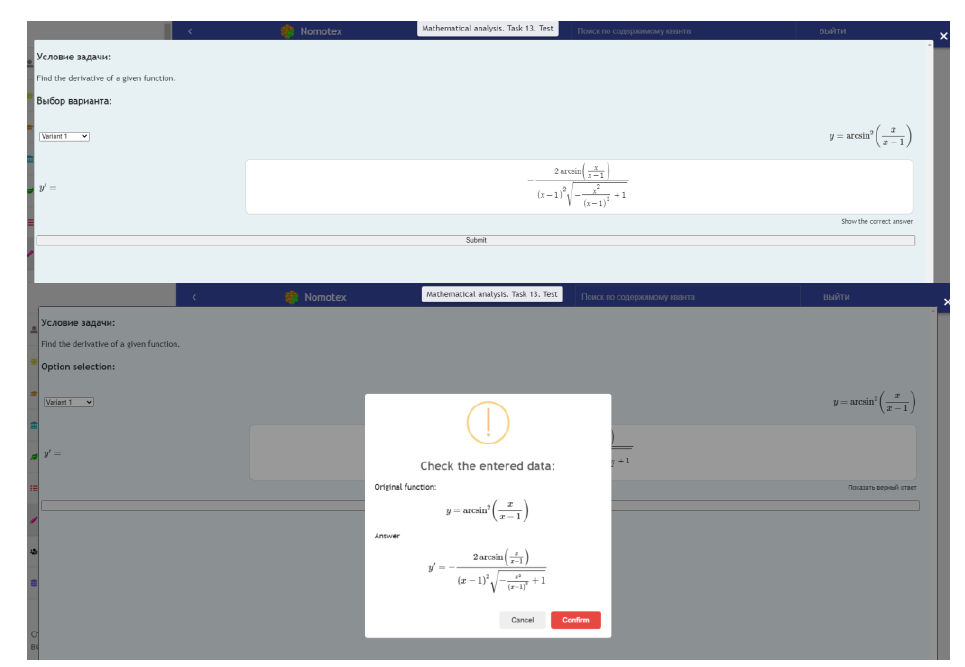
Fig. 6. Checking the solution in the DLS "Nomotex"